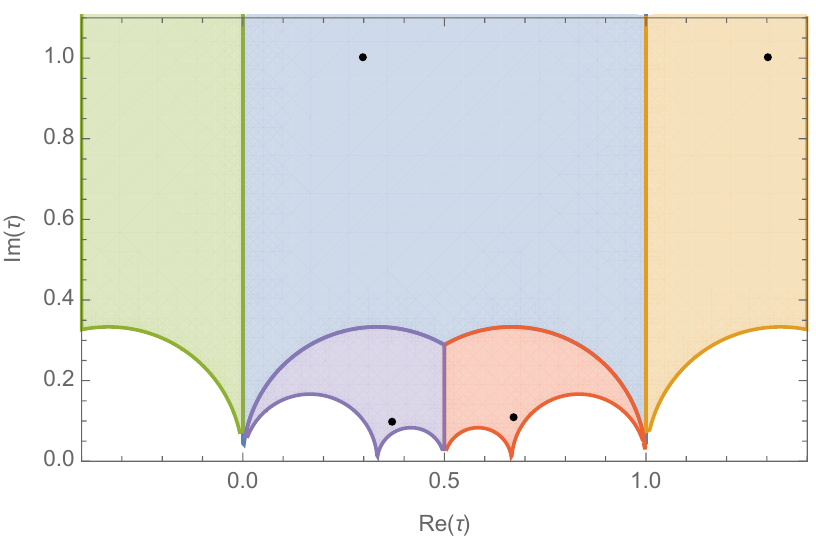
Figure 2 . Copies of the fundamental domain of (cid:0) 1 (3) by its action. The dots are the copies of the point 0 : 3 + i